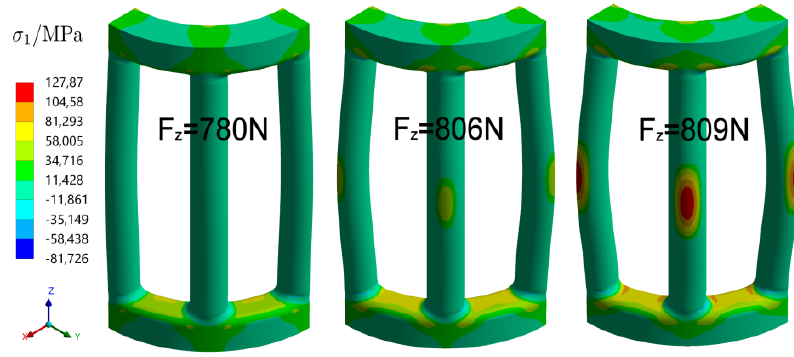
Figure 11. Comparison of uniaxial load sets (deformation shown in true scale).